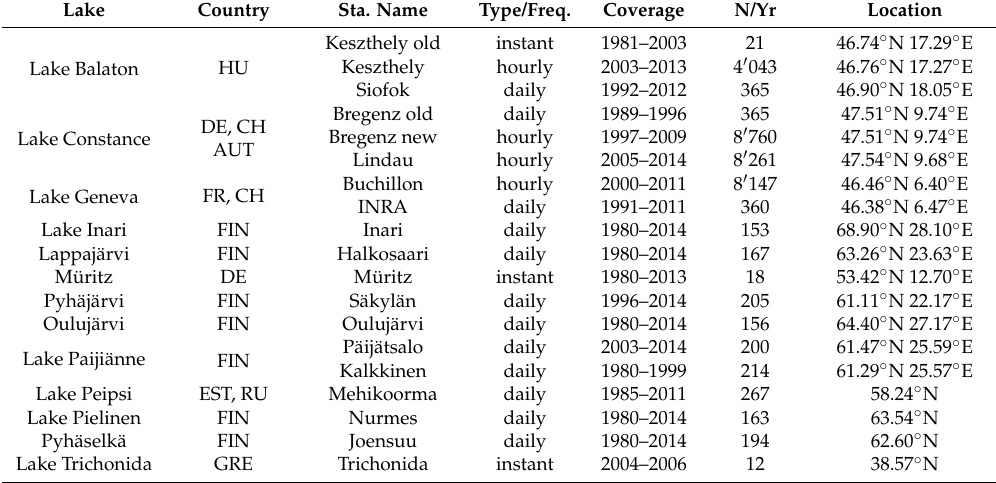
Table 2. List of in-situ measuring locations from which data was available for this study. Most of the measurements are either hourly or daily averaged temperatures from automatic stations. In the case of Müritz, Lake Trichonida, and the older measurements from Lake Balaton, the measurements are sporadically and manually taken at specific locations on the lake. The average measurement density varies from 12 measurements per year at Lake Trichonida (monthly measurements) to 8760 measurements per year at Bregenz, Lake Constance (hourly